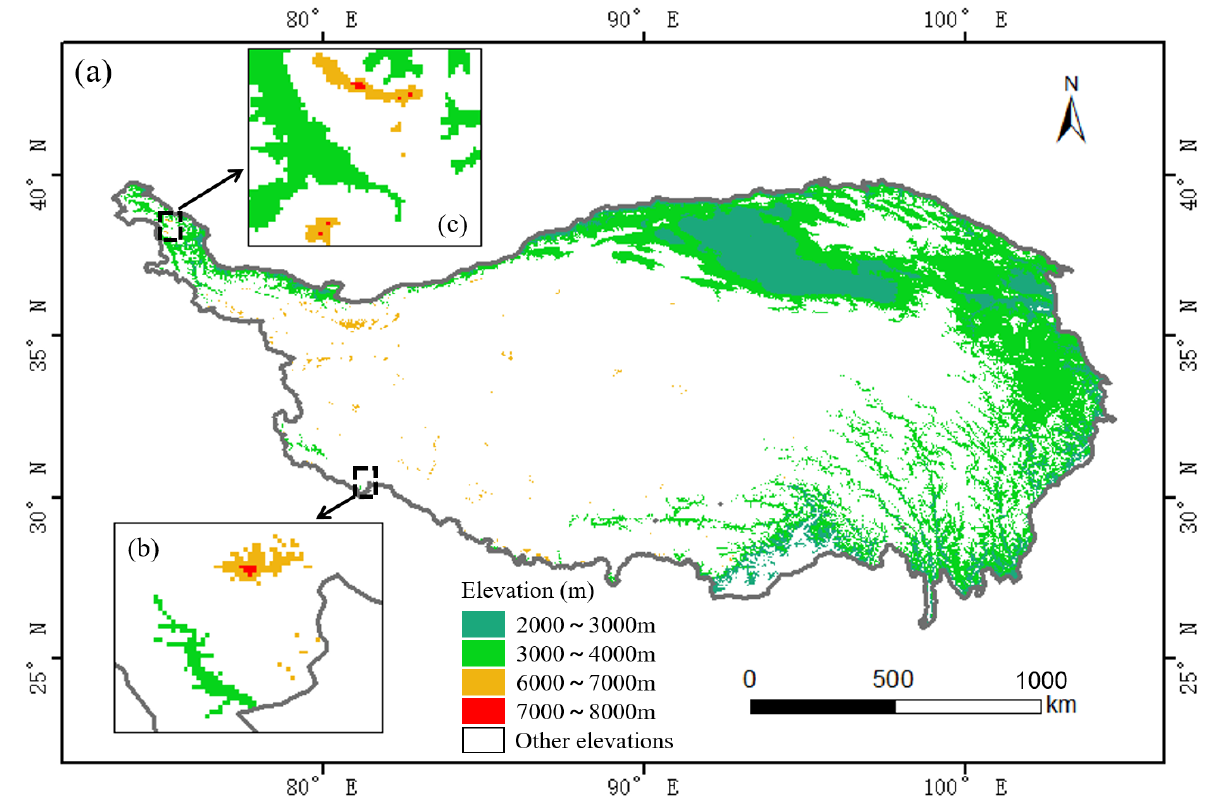
Figure 15. Elevation (2000 ~ 3000 m, 3000 ~ 4000 m, 6000 ~ 7000 m and 7000 ~ 8000 m) distribution of QTP ( a ). Demonstration of elevation of 7000 ~ 8000 m ( b , c ).